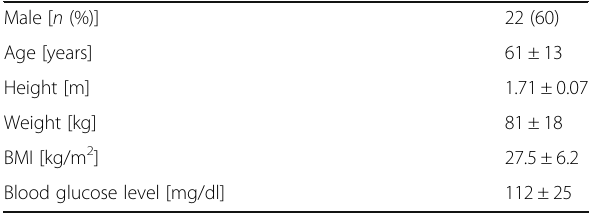
Table 1 Patients characteristics. Continuous measures are reported as mean with the corresponding standard